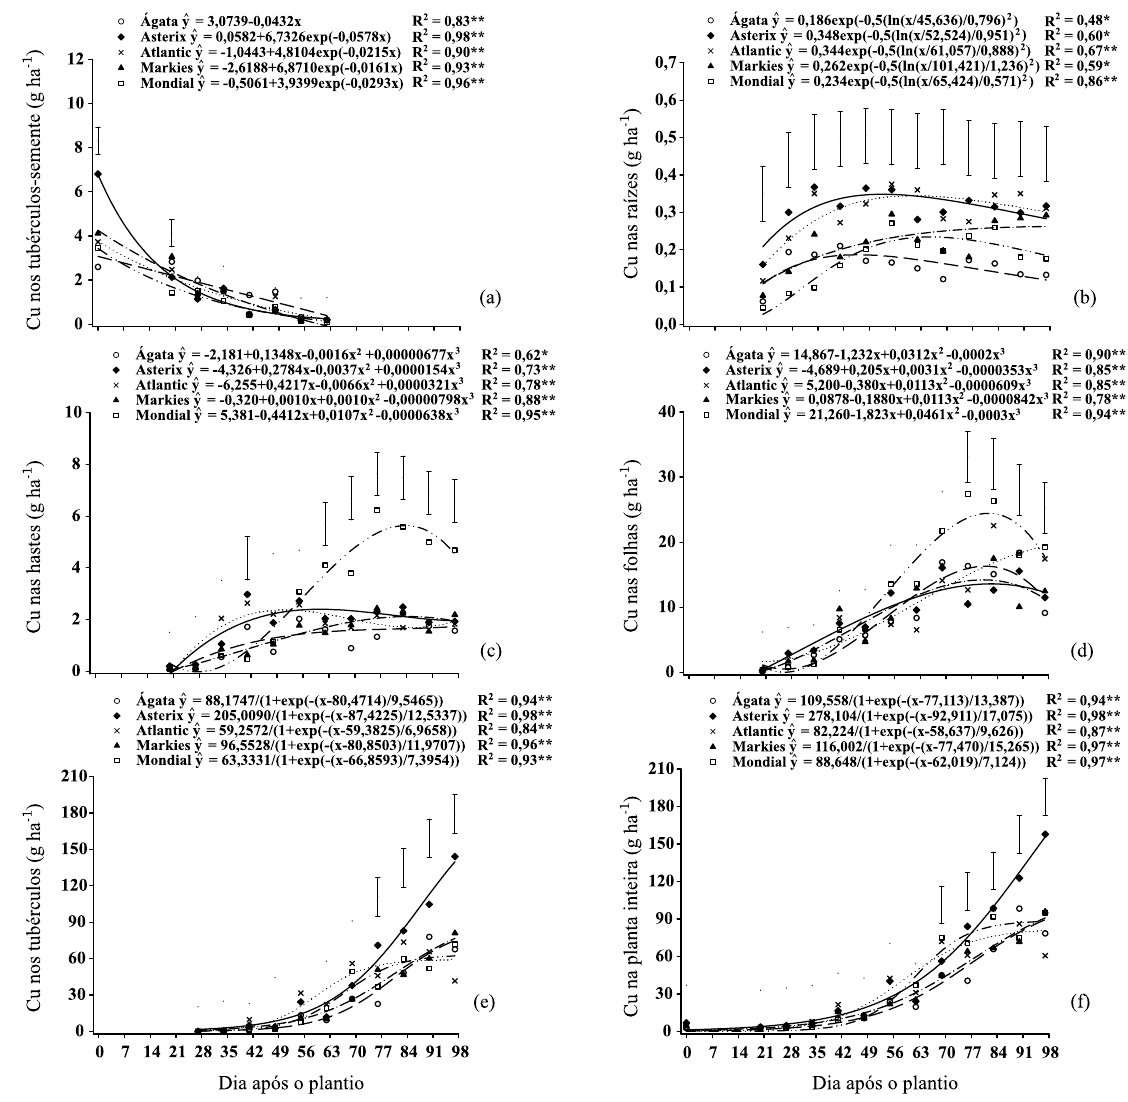
Figura 3. Quantidade de Cu nos tubérculos-semente (a), raízes (b), hastes (c), folhas (d), tubérculos (e) e na planta inteira (f) de cultivares de batata ao longo do ciclo. ** significativo a 1 % pelo teste F. Barras verticais indicam o valor de DMS pelo teste de Tukey a 5